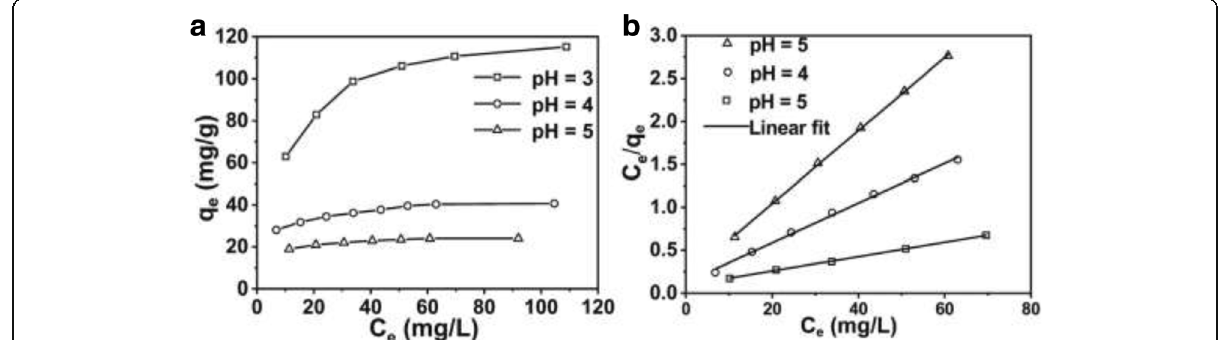
Fig. 8 a The removal capacity of Cr (VI) at different equilibrium concentration (solution pH respectively at 3, 4, and 5), and b corresponding Langmuir removal isotherm